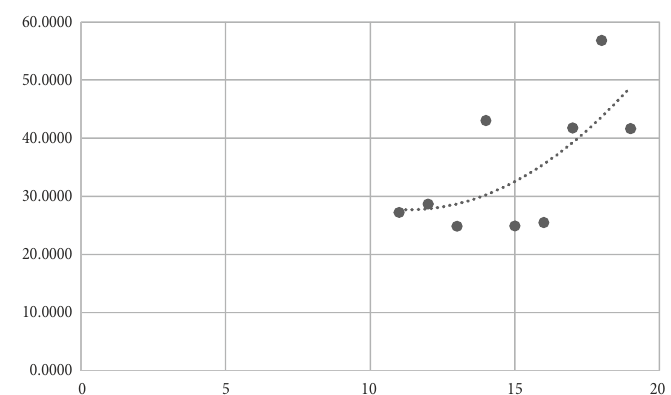
Fig.1A. Graphical representation of mean ROE by intangible assets intervals (polynomial